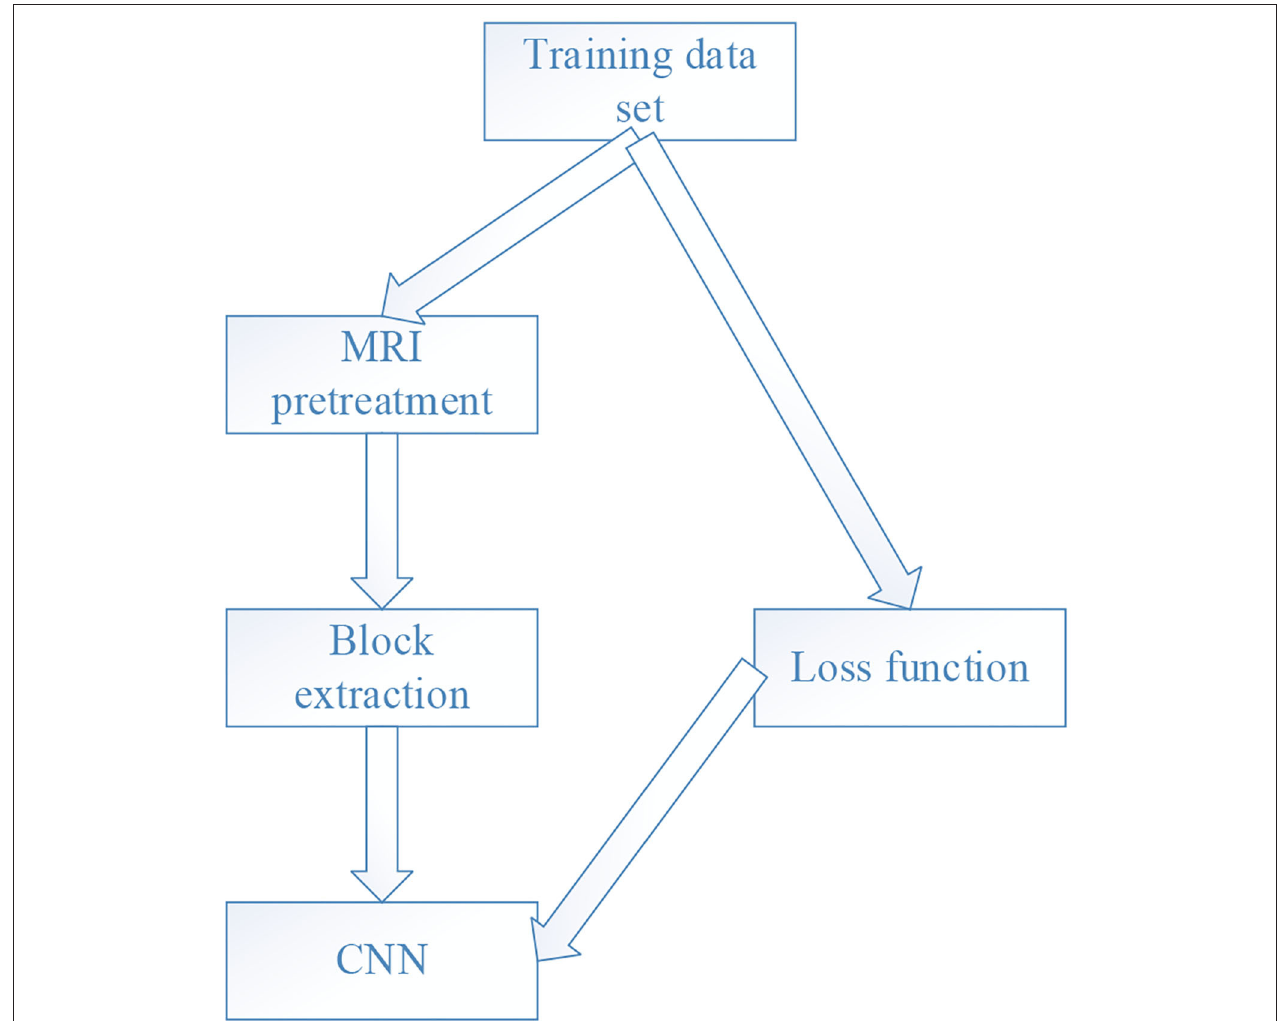
FIGURE 1 | CNN algorithm flow.